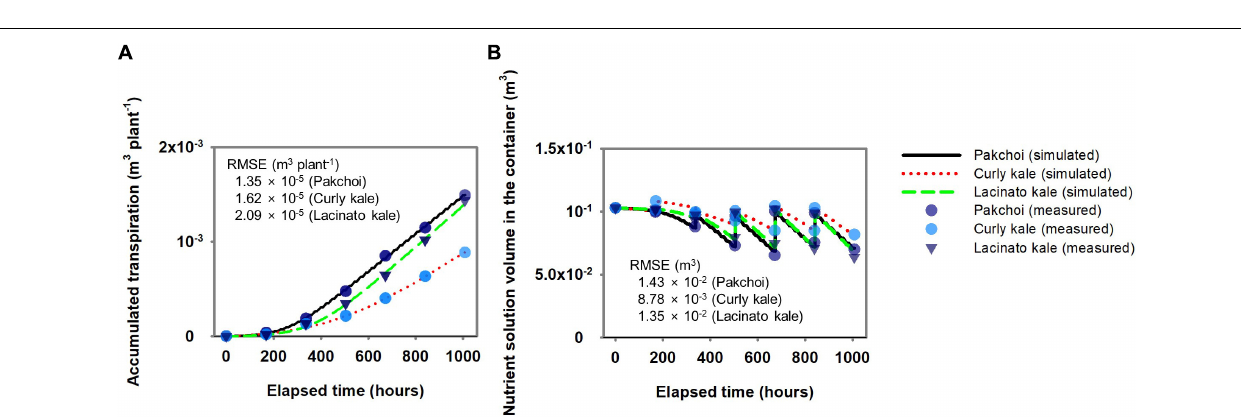
FIGURE 3 | Comparison between simulated and measured accumulated transpiration (A) and subsequent changes of nutrient solution volume changes in the nutrient solution container (B) for verifying the simple hydroponic system